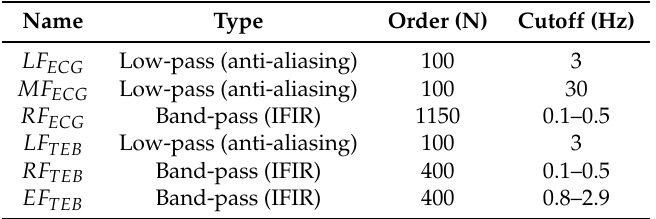
Table 1. Types of filters and computational